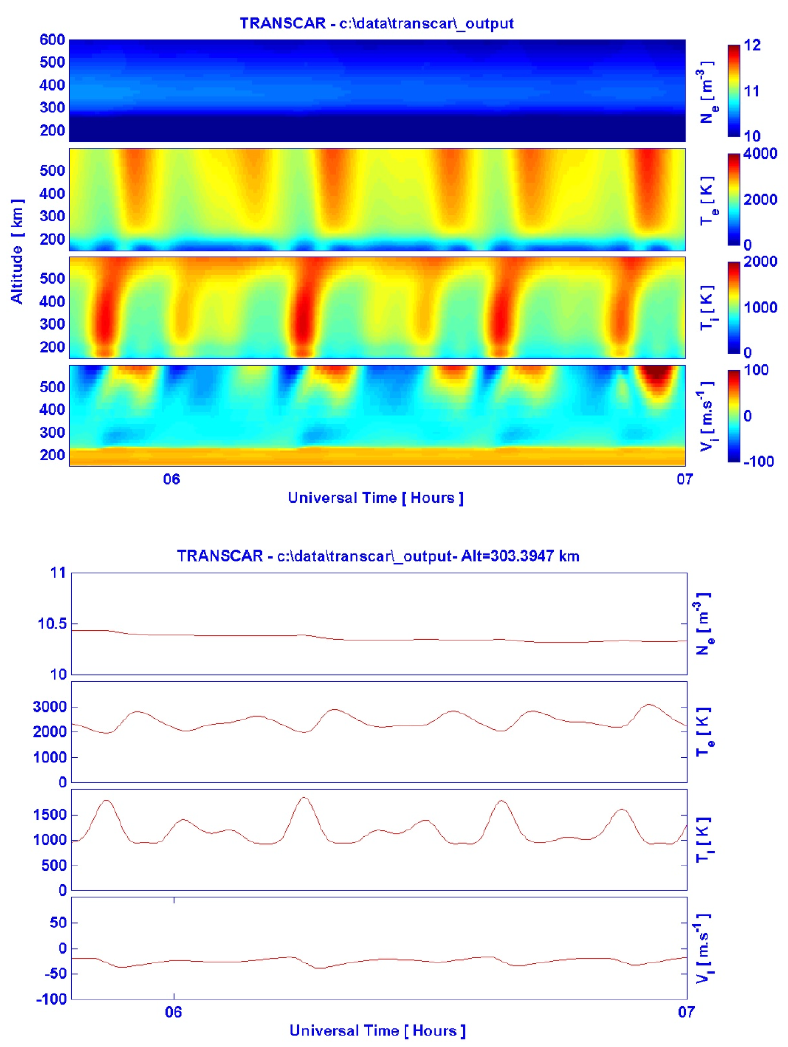
Fig. 8. Ionospheric plasma parame- ters modelled by TRANSCAR. Upper panel, from top to bottom: N e , elec- tron density, T e , electron temperature, T i , ion temperature, and line-of-sight velocity, V i (positive away from the radar) as a function of time and altitude. Lower panel: time series of the same parameters modelled at 300km of alti-